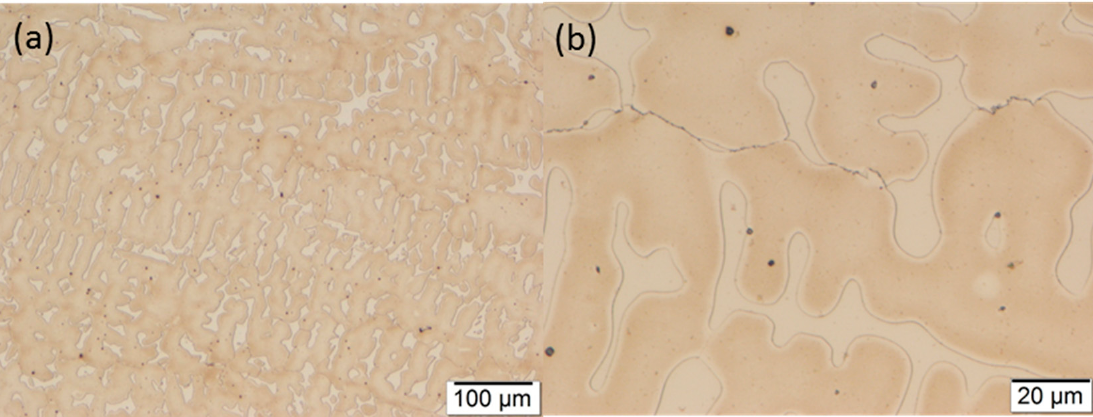
Figure 2. Optical microscopy of the as cast duplex microstructure, etched with 10% nital, ferrite––white, and austenite–– brown ( a ) typical dendritic morphology, ( b ) somewhat enhanced etching of grain boundaries–possible precipitation.